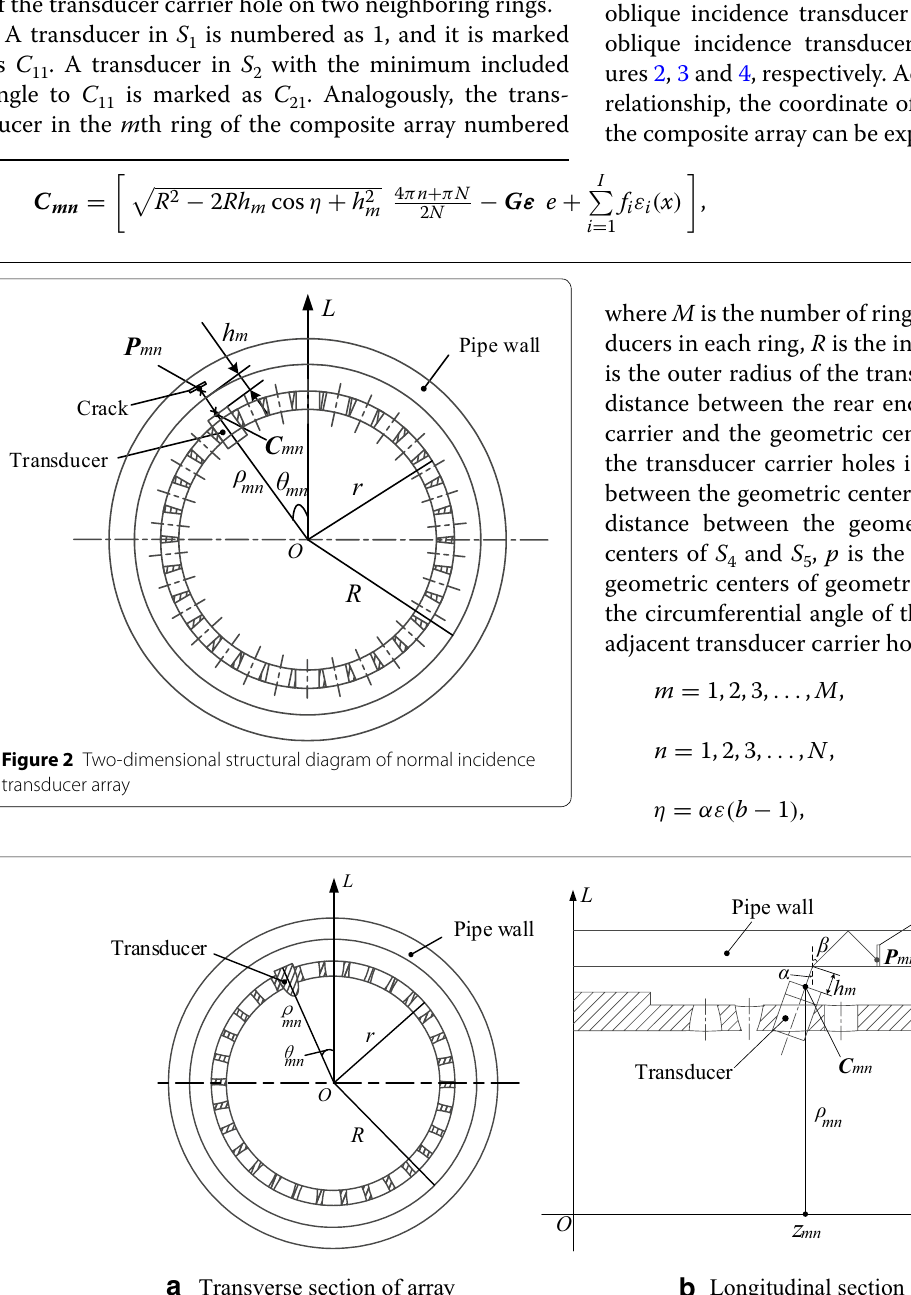
a Transverse section of array b Longitudinal section of array Figure 3 Two‑dimensional structural diagrams of axial oblique incidence transducer